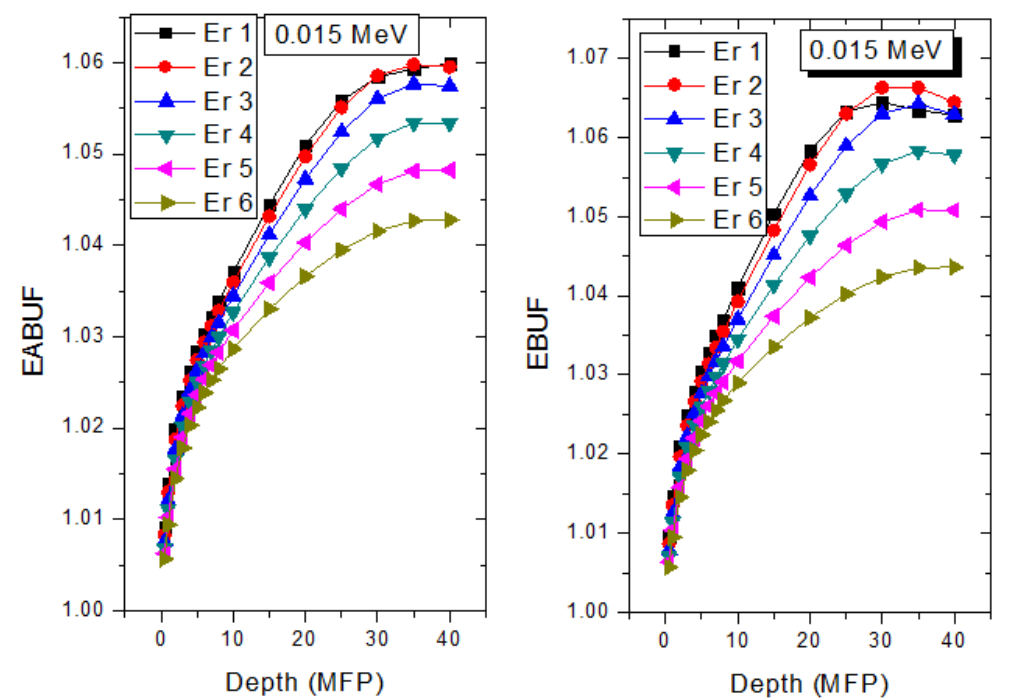
Materials 2021 , 14 , x FOR PEER REVIEW Figure 7. Effect of chemical composition on EABUF and EBUF at different depth for 0.015 MeV photon energy.